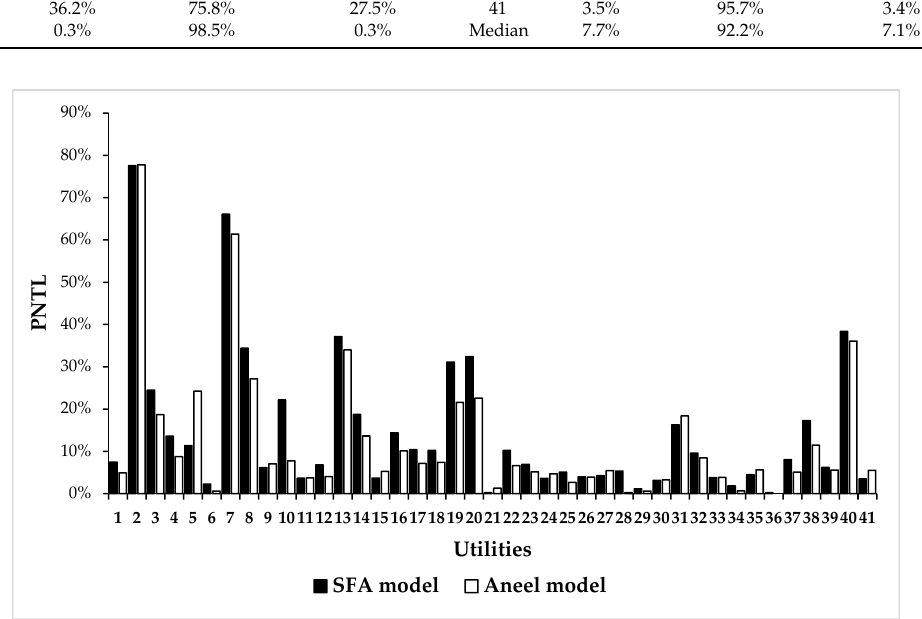
Figure 13. PNTL targets from the SFA model and the ANEEL’s model for 2018 [9].